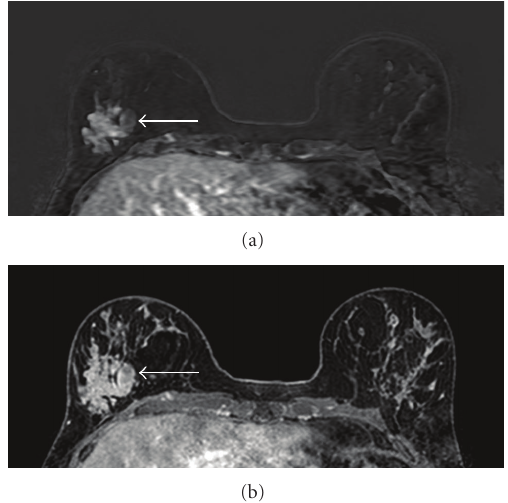
Figure 3: Contrast-enhanced (subtraction) MR images (a) and contrast-enhanced T1-weighted MR images (b) show a large, lobu- lated heterogeneously enhancing mass with irregular borders in the lower lateral quadrant of the right breast